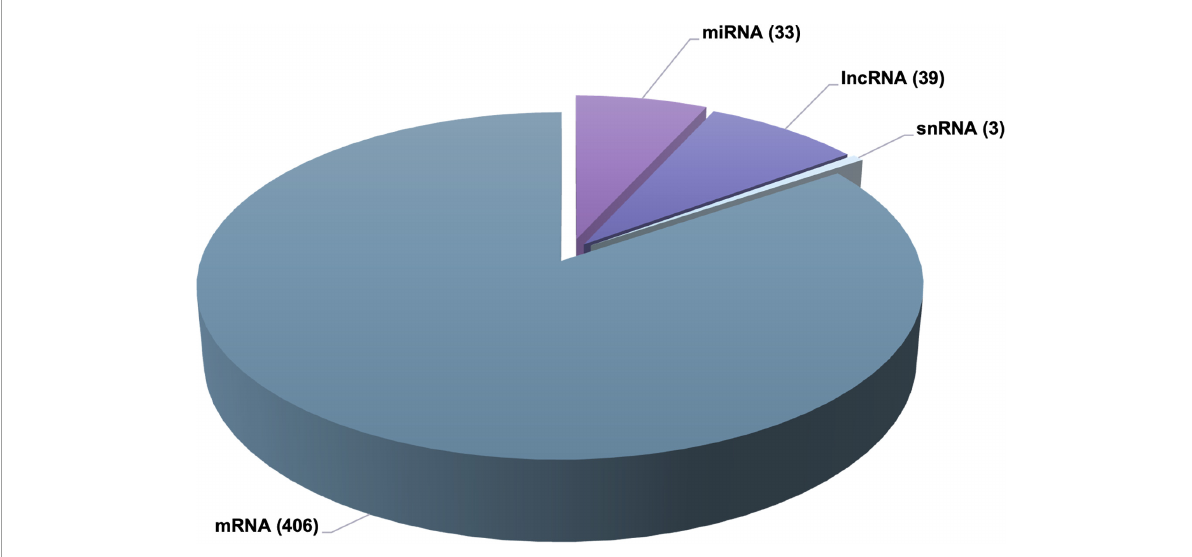
FIGURE2 Pie chart of the number of differentially expressed mRNAs, miRNAs, and lncRNAs in diabetic rats treated with anthocyanin-rich black beans